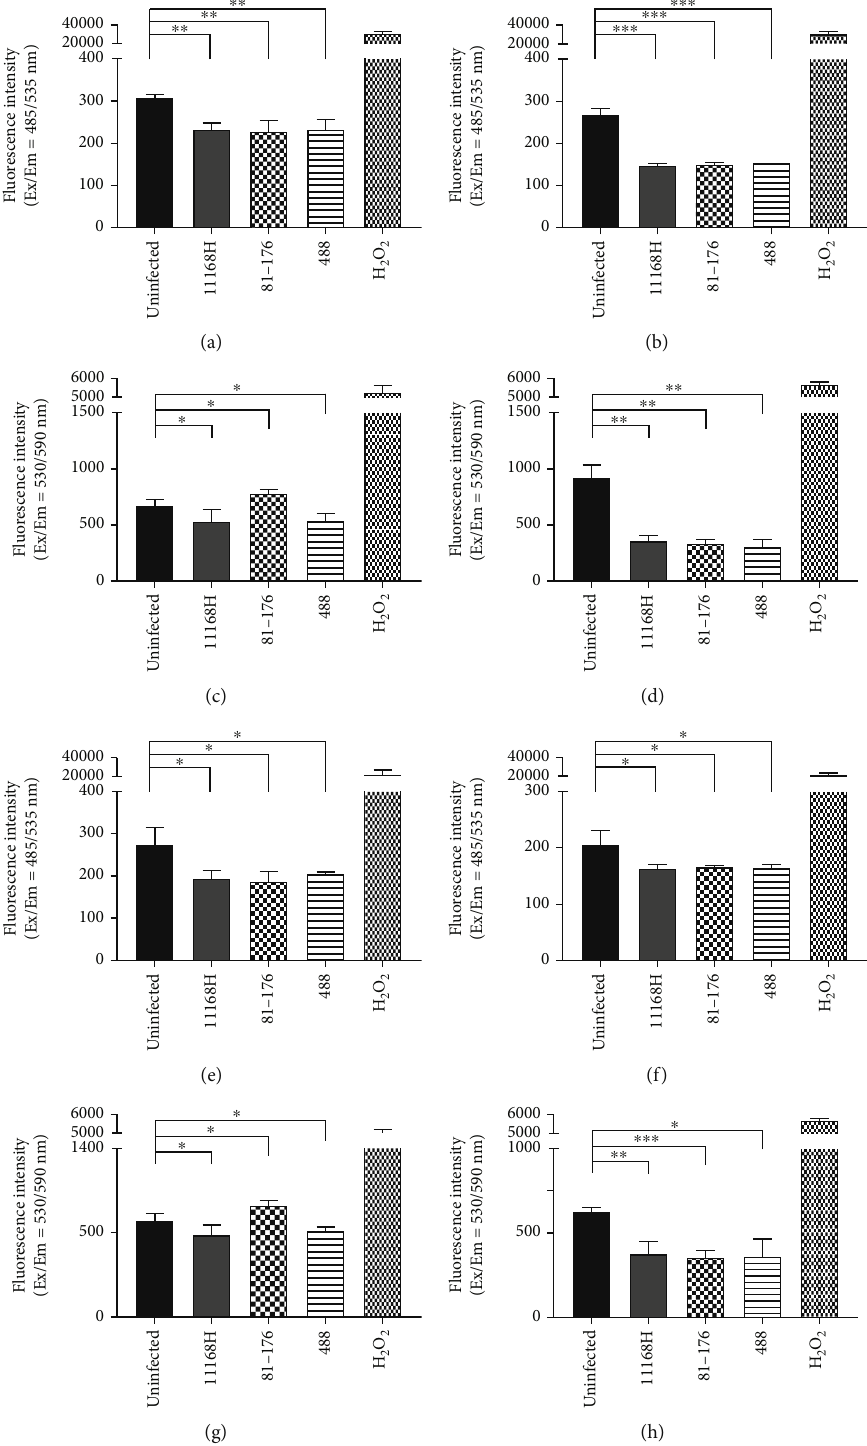
Figure 1: Detection of intracellular and extracellular ROS in T84 and Caco-2 cells after infection with C. jejuni 11168H, 81-176, or 488 strains. Intracellular ROS in T84 cells after infection with C. jejuni for (a) 3 hours or (b) 24 hours and extracellular ROS from T84 cells after infection with C. jejuni for (c) 3 hours or (d) 24 hours were measured. Intracellular ROS in Caco-2 cells after infection of C. jejuni for (e) 3 hours or (f) 24 hours and extracellular ROS from Caco-2 cells after infection for (g) 3 hours or (h) 24 hours were measured. For detection of intracellular ROS, DCFDA was used. For detection of extracellular ROS, Amplex® Red reagent with HRP was used. O was used as a positive control. Experiments were repeated in three biological and three technical replicates. Asterisks denote a H 2 2 statistically signi fi cant di ff erence ( ∗ p < 0 : 05 ; ∗∗ p < 0 : 01 ; ∗∗∗ p < 0 : 001